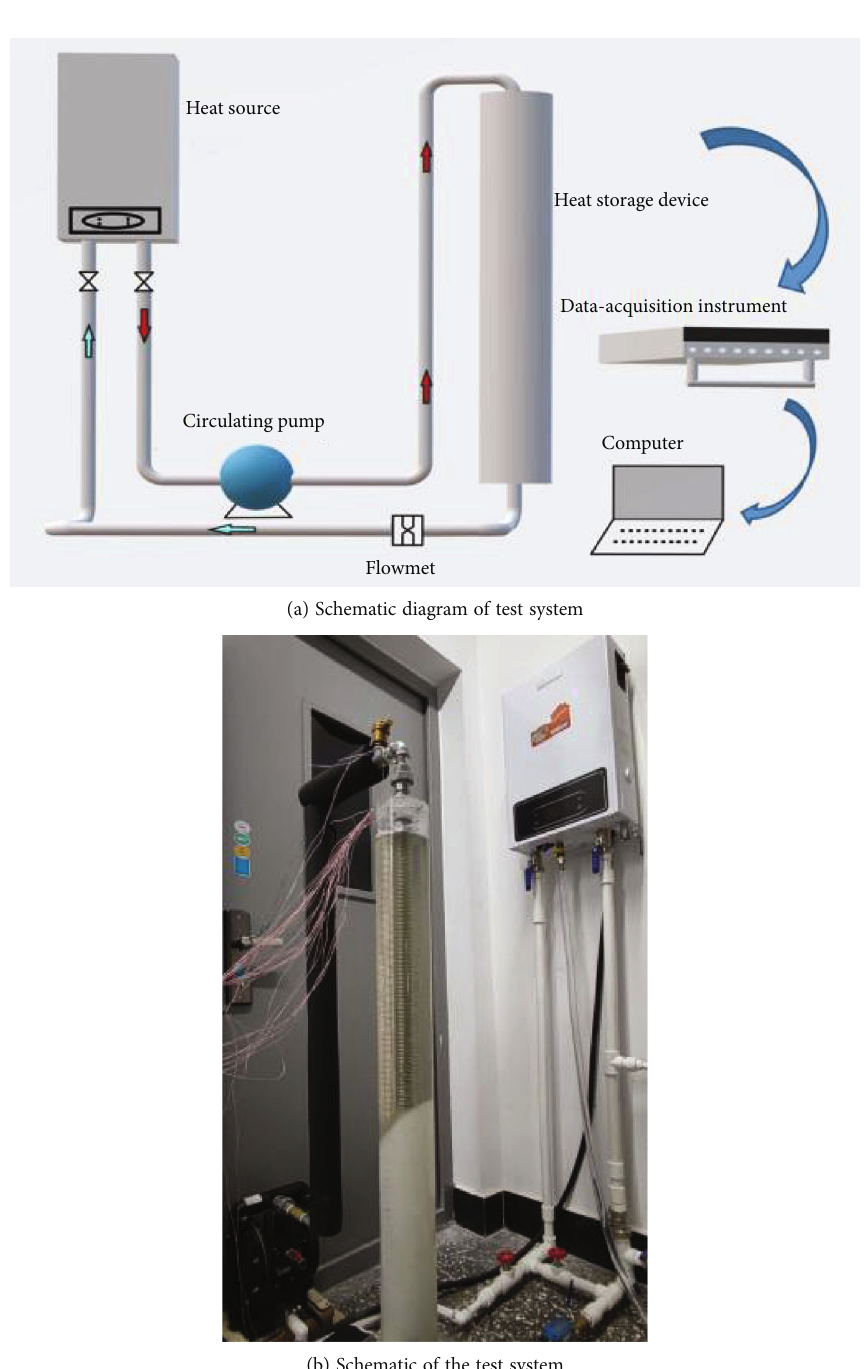
Figure 3: Test system